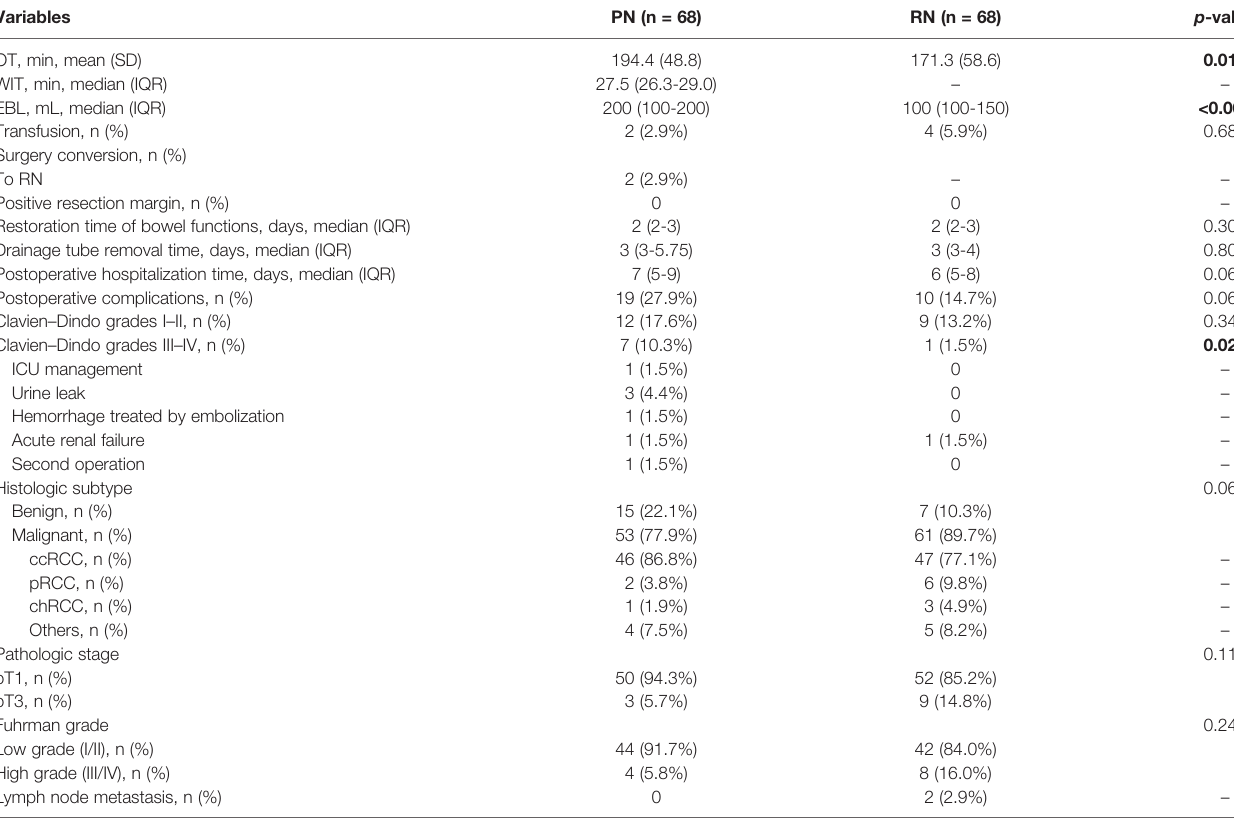
TABLE 2 | Perioperative and oncological outcomes for PN and RN after propensity score matching. Variables